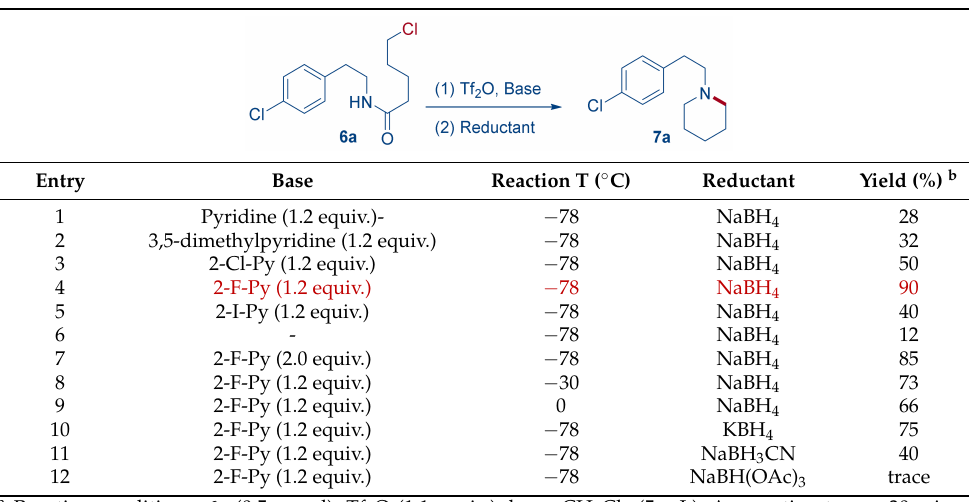
Table 1. Optimization of reaction conditions a